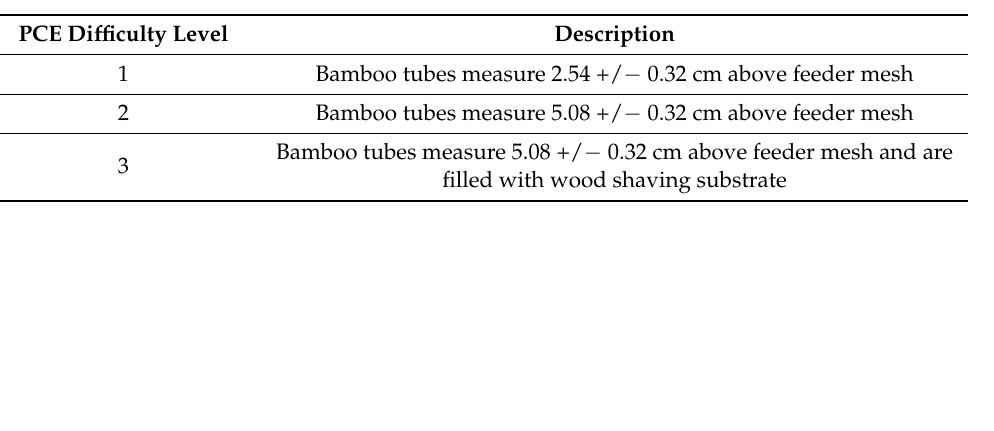
Table 2. Progressively challenging enrichment item difficulty